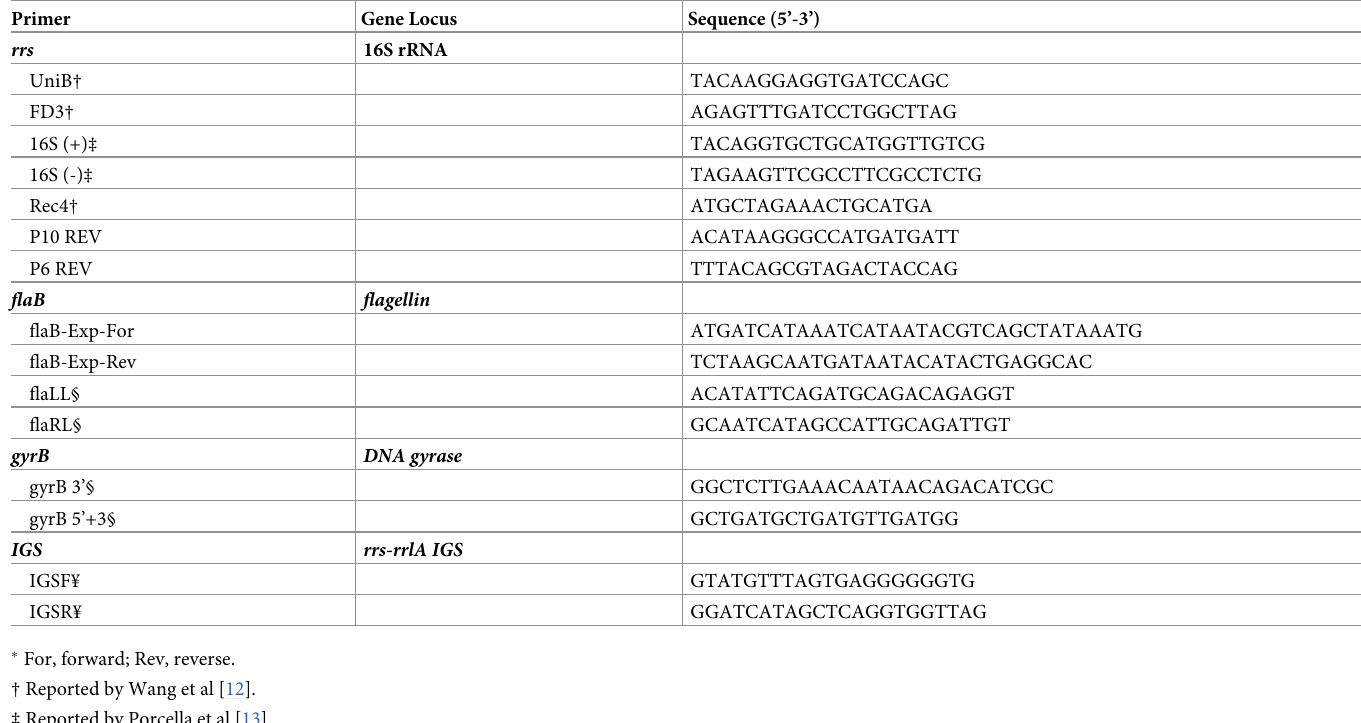
Table 1. Oligonucleotides used for PCR and MLSA of TBRF spirochetes. Primer Gene Locus Sequence